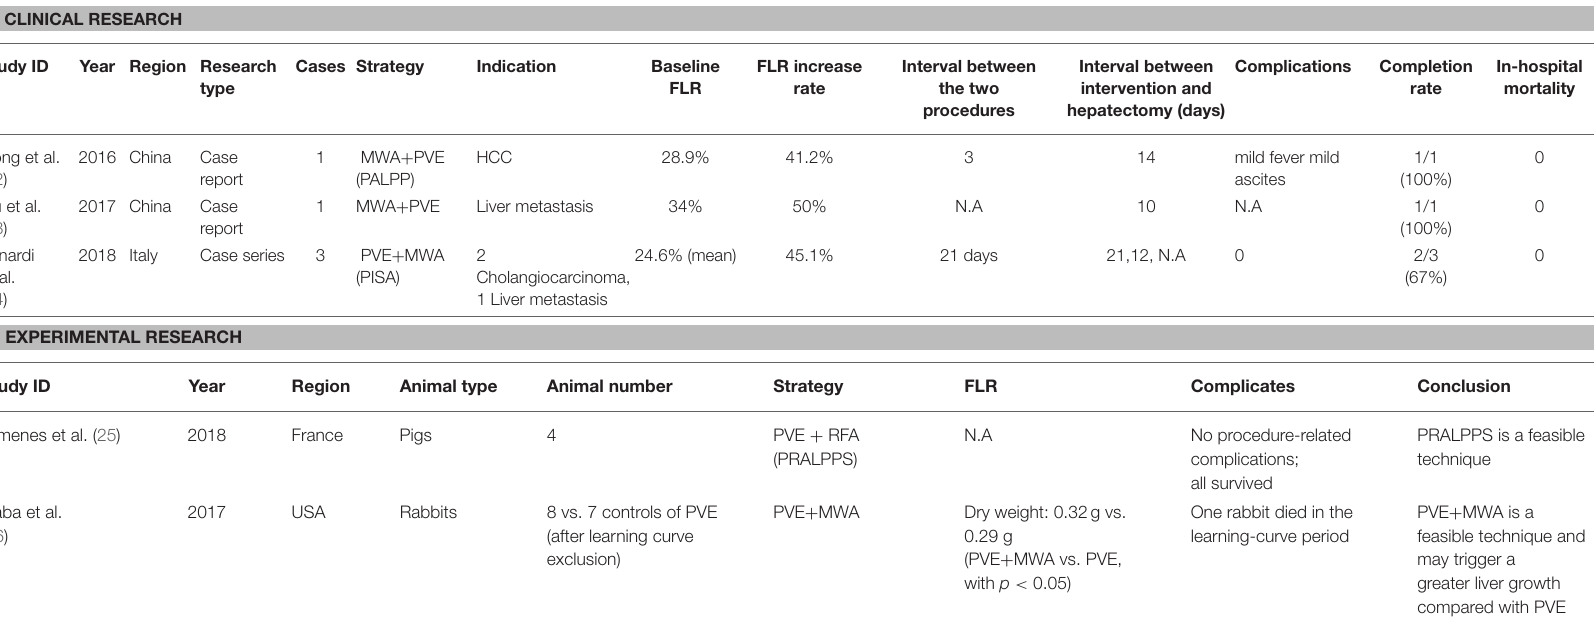
TABLE 5 | Summary of studies about the strategy combining PVE and RFA/MWA for FLR